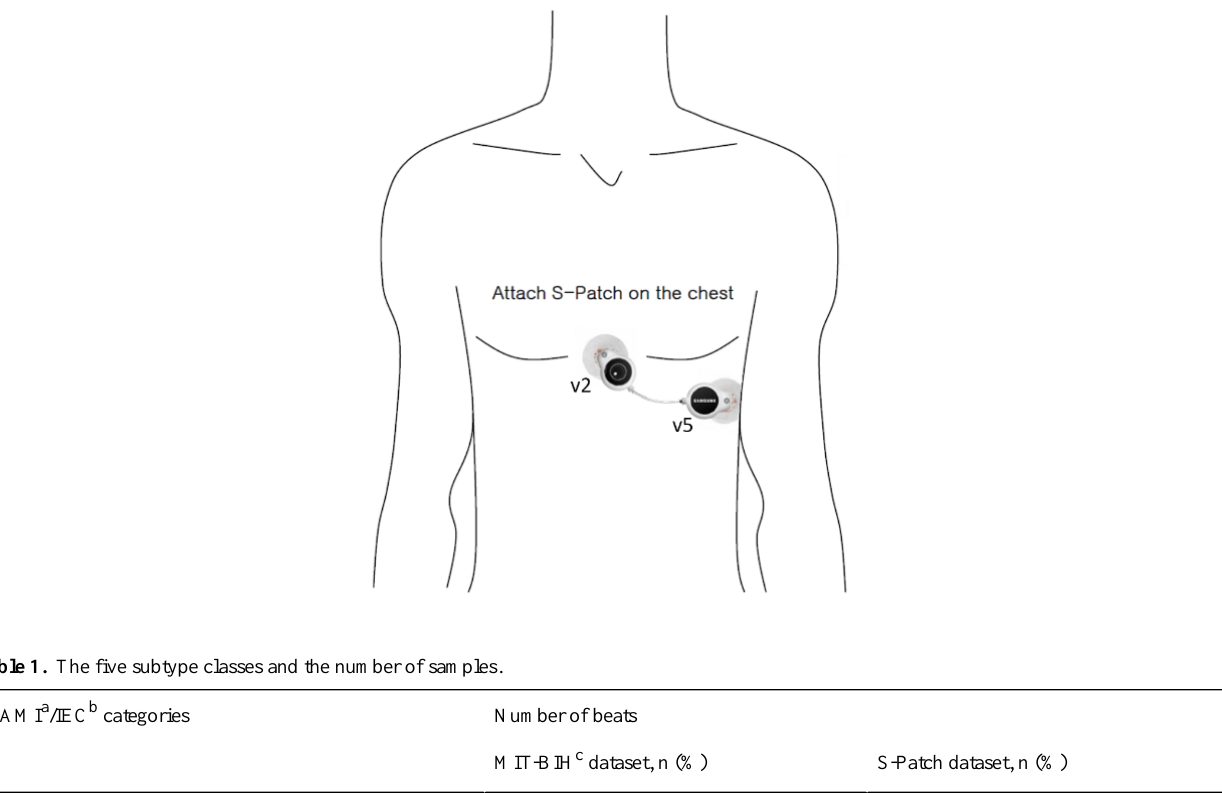
Figure 1. Usage of S-Patch for Samsung SDS Cardio.